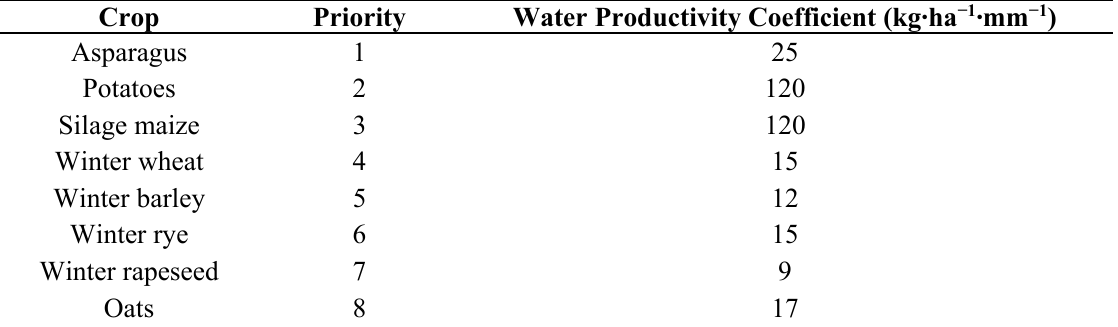
Table 2. Crop irrigation priorities and water productivity